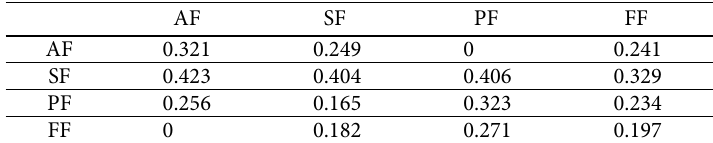
Table 9. Degree of relative impact for factors AF SF PF FF AF